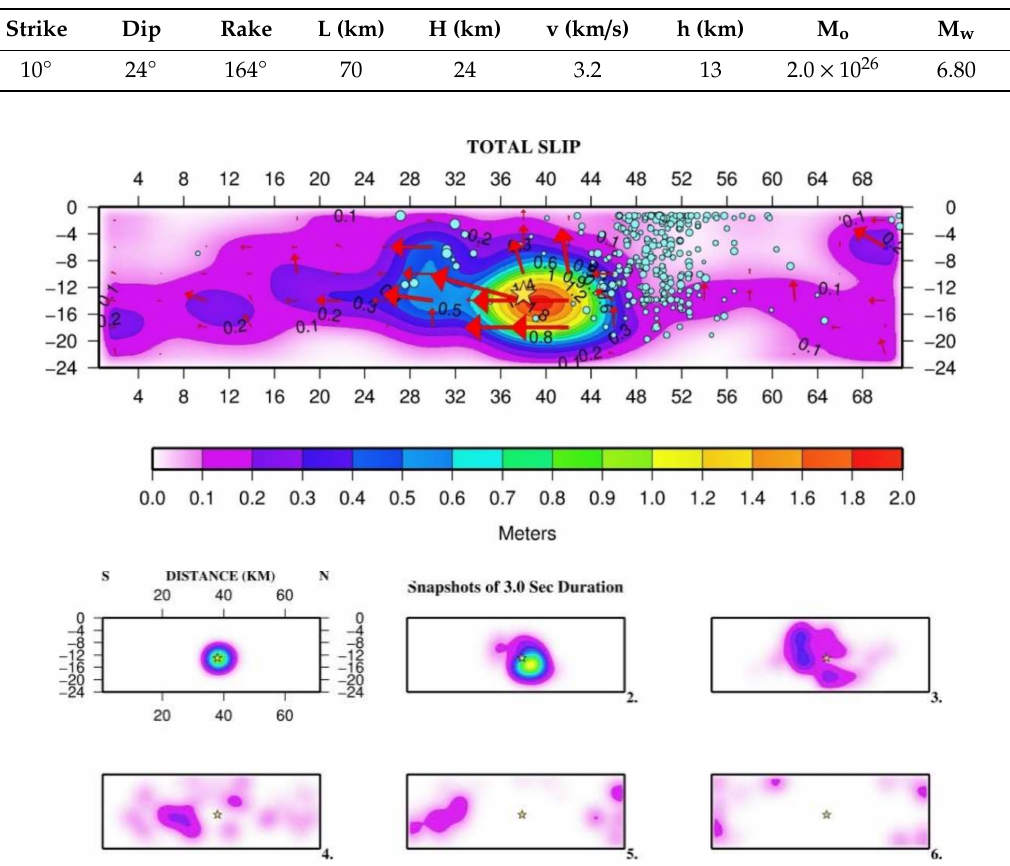
Table 2. Best fit model parameters for the fault plane. L: fault length, H: depth of faulting, v: rupture